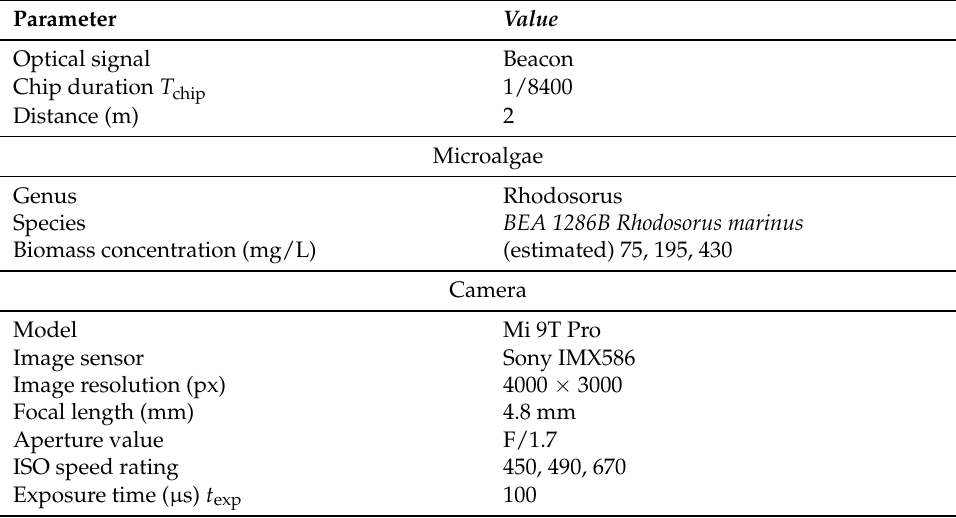
Table 3. Outdoor experiment key